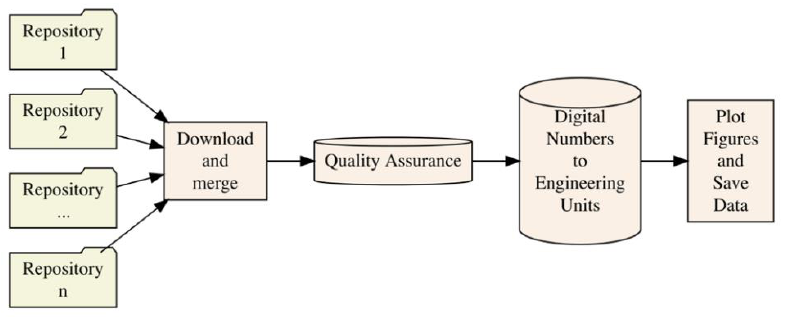
Figure 2. Conceptual workflow of the data curation process within the ttalkR package from the data download to the figures and data saving.